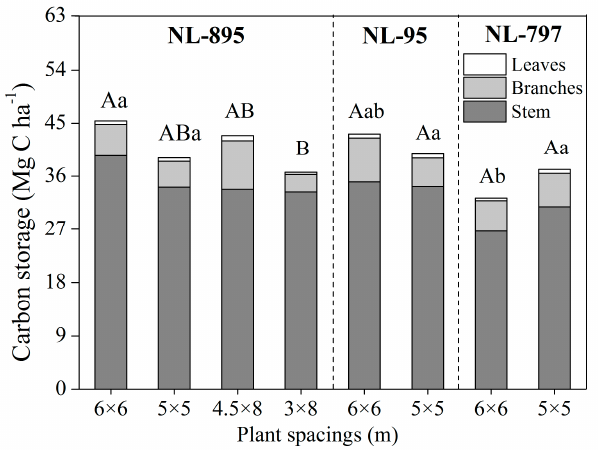
Figure 4. Effects of poplar clones and planting spacings on aboveground carbon storage in 13-year-old poplar plantations. Different capital letters indicate significant differences ( p < 0.05) by Tukey test between spacings for each clone, while different small letters indicate significant differences ( p < 0.05) by Tukey test between clones within each planting spacing.